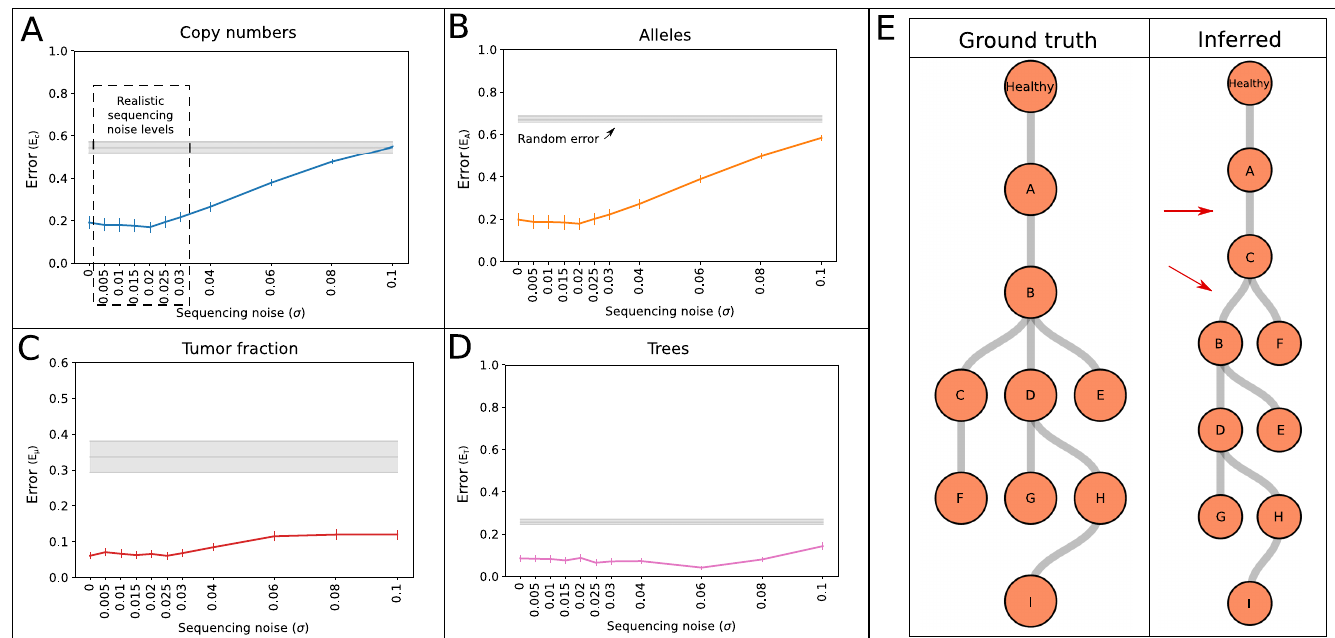
Fig 3. (A-D) The error of inferring ~ C , ~ A , μ and T as a function of sequencing noise. For every noise level, the mean of the error and 95% confidence interval are reported across 101 simulated datasets, each with a unique μ between 0 and 1. The grey shaded areas represent the mean of the error and 95% confidence intervals in 101 simulated datasets where random AF and SNV measurements were selected. (E) Example of a simulated tree (ground truth) compared to the tree inferred by TargetClone. The red arrows indicate incorrectly placed